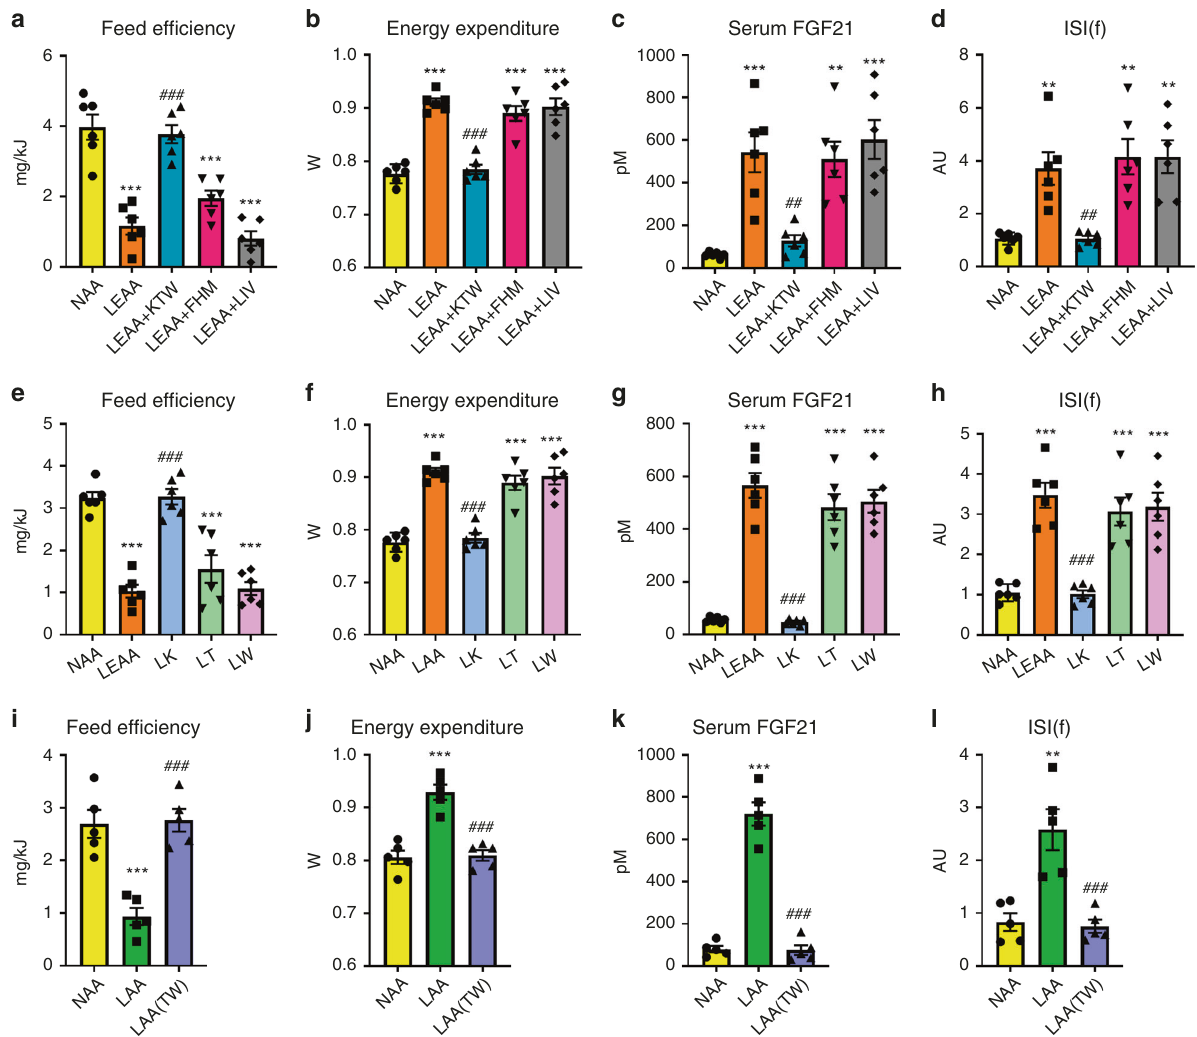
Fig. 3 Certain essential amino acids including threonine and tryptophan are suf fi cient and necessary for the systemic metabolic effects of dietary protein dilution. a Feed ef fi ciency of mice in response to a 3-week treatment with diets containing 18% from amino acids (normal amino acid; NAA), 4.5% essential AA (LEAA; as of diet E in Fig. 2c), and LEAA supplemented with either lysine, threonine, and tryptophan (LEAA + KTW), phenylalanine, histidine, and methionine (LEAA + FHM), or isoleucine, leucine, and valine (LEAA + ILV), all with other AA equally adjusted to give 18% AA in total. Data are mean and SEM ( n = 6 individual mice per group). Data were analysed by one-way ANOVA with Holm – Sidak post-hoc tests. Different than diet NAA: * P < 0.05, ** P < 0.01, *** P < 0.001. Different than diet LEAA: # P < 0.05, ## P < 0.01, ### P < 0.001. b Energy expenditure of mice as in ( a ). c Serum fi broblast growth factor 21 (FGF21) levels of mice as in ( a ). d Insulin sensitivity index during fasting (ISI(f)) of mice as in ( a ). e Feed ef fi ciency of mice in response to a 3- week treatment with diets containing 18% from amino acids (AA; NAA), 4.5% essential AA (LEAA; as of diet E in Fig. 2c), and diet singly with restricted amounts of lysine (LK), threonine (LT), and tryptophan (LW), all with other AA equally adjusted to give 18% AA in total. Data are mean and SEM; n = 6 individual mice per group. Data were analysed by one-way ANOVA with Holm – Sidak post-hoc tests. Different than diet NAA: * P < 0.05, ** P < 0.01, *** P < 0.001. Different than diet LEAA: # P < 0.05, ## P < 0.01, ### P < 0.001. f Energy expenditure of mice as in ( e ). g Serum FGF21 levels of mice as in ( e ). h ISI(f) of mice as in ( e ). i Feed ef fi ciency of mice in response to a 3-week treatment with diets containing 18% from amino acids (normal amino acid; NAA), 4.5% AA (LAA; as of diet B in Fig. 2c), and LAA supplemented with threonine and tryptophan while keeping total AA at 4.5% (LAA(TW)). Data are mean and SEM ( n = 5 individual mice per group). Data were analysed by one-way ANOVA with Holm – Sidak post-hoc tests. Different than NAA: * P < 0.05, ** P < 0.01, *** P < 0.001. Different than LAA: # P < 0.05, ## P < 0.01, ### P < 0.001. j Energy expenditure of mice as in ( e ). k Serum FGF21 levels of mice as in ( e ). l ISI(f) of mice as in ( e